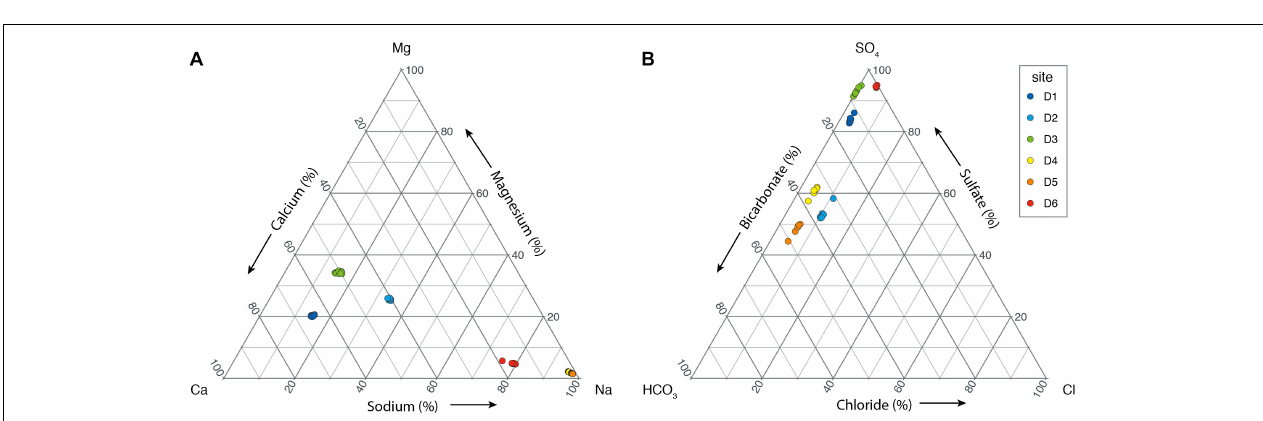
FIGURE 3 | Water isotopes of DeMMO sites and overlying land (A) Plot of water isotopes for DeMMO sites plotted on the meteoric water line and OIPC estimates of monthly average and annual precipitation. Inset expands borehole data range. (B) Box plots showing variability with time in both δ 18 O and δ 2 H where points are colored by the sampling date.